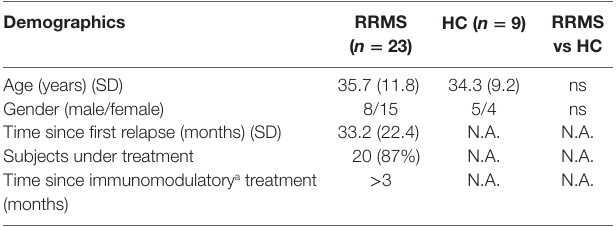
For each subject, all images were registered in the MP2RAGE space using Elastix c ++ library (33). Morphobox (34) was